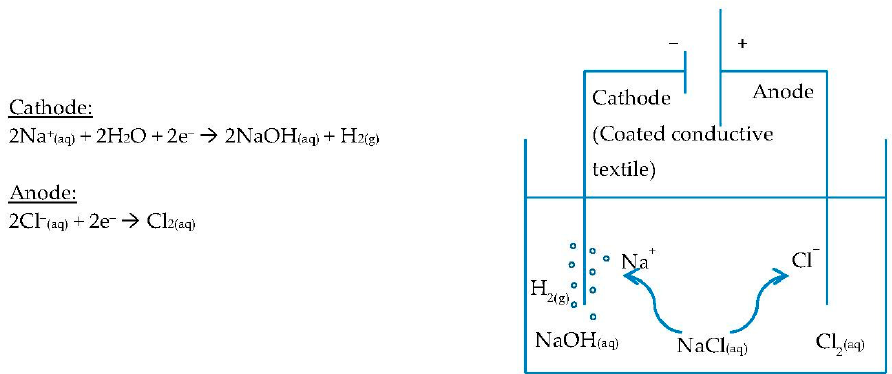
Figure 4. Pinhole test.